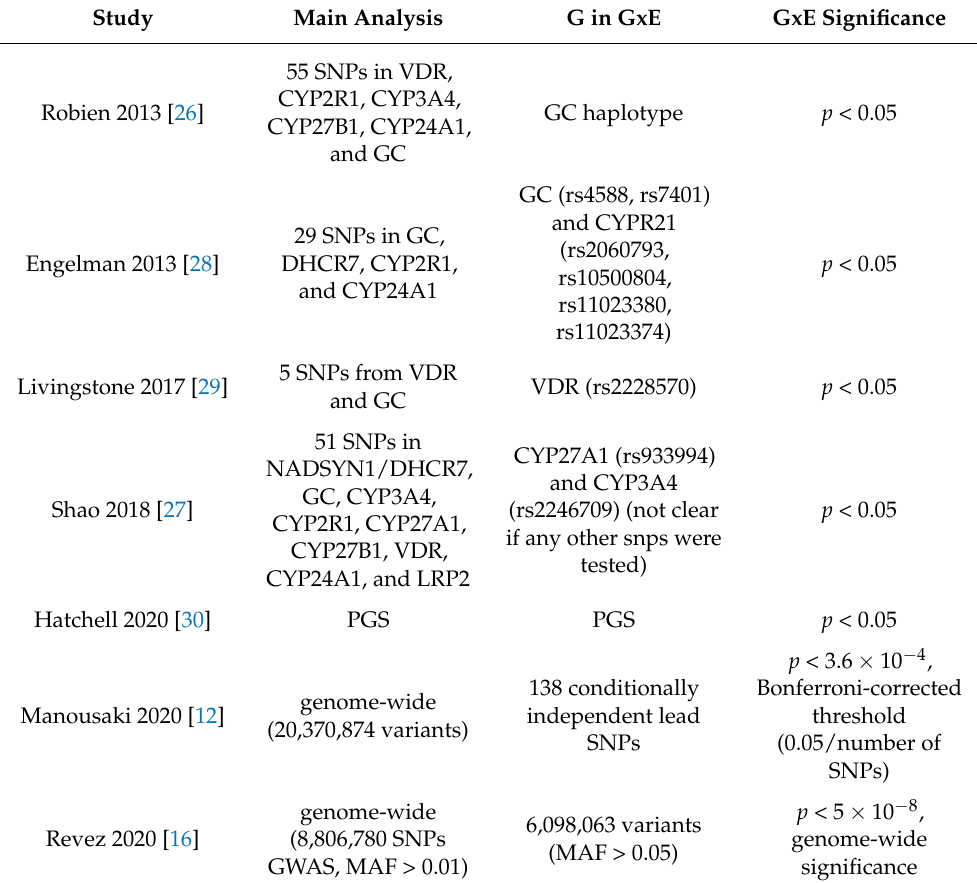
Table 2. Genetic variants tested in each study in the main genetic analysis, the subset that was used in the GxE interaction analysis, and the significance threshold used for the latter. Study Main Analysis G in